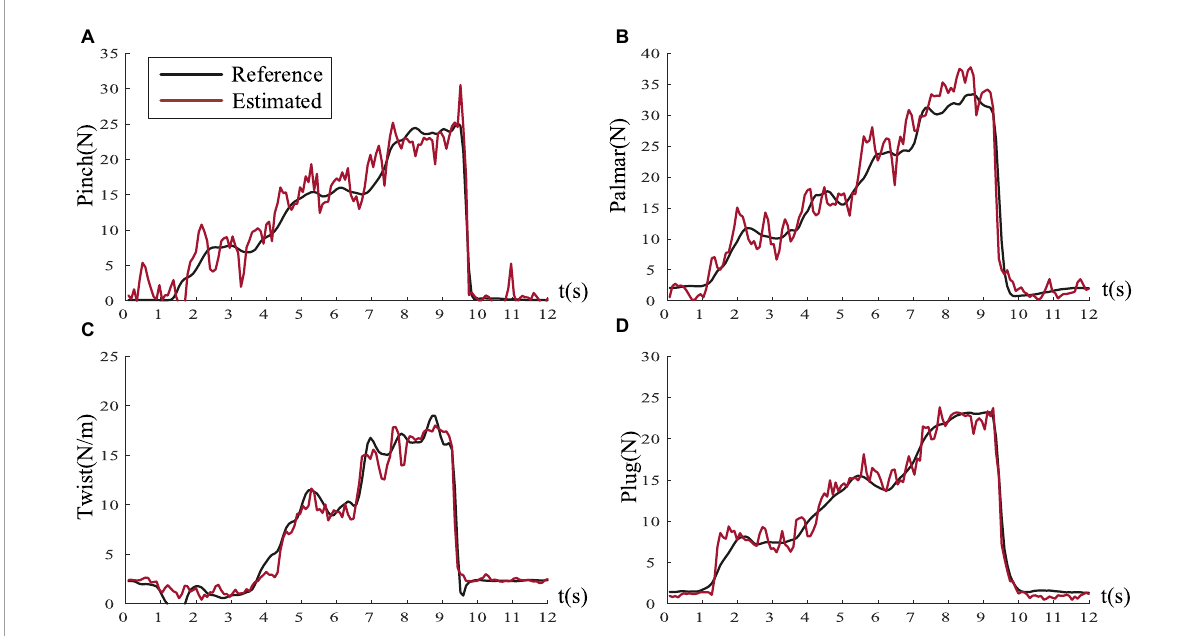
FIGURE10 The estimation results of four grasping forces under the step-climbing profile (Take subject three as an example). (A) Pinch force ( R 2 = 0.9343). (B) Palmar force ( R 2 = 0.9423). (C) Twist force ( R 2 = 0.9694). (D) Plug force ( R 2 = 0.9755).